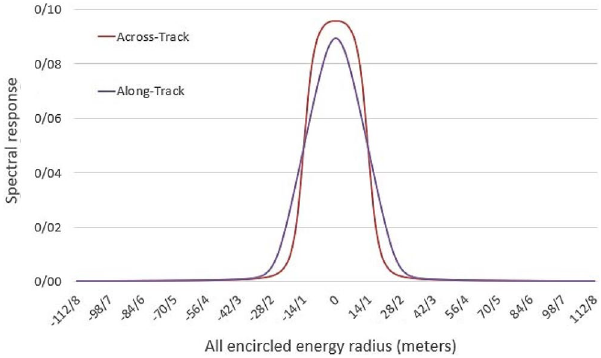
Figure 2. Across- and along-track spectral response of neighboring pixels of a given pixel to the energy acquired by the OLI B4 (red channel) 28